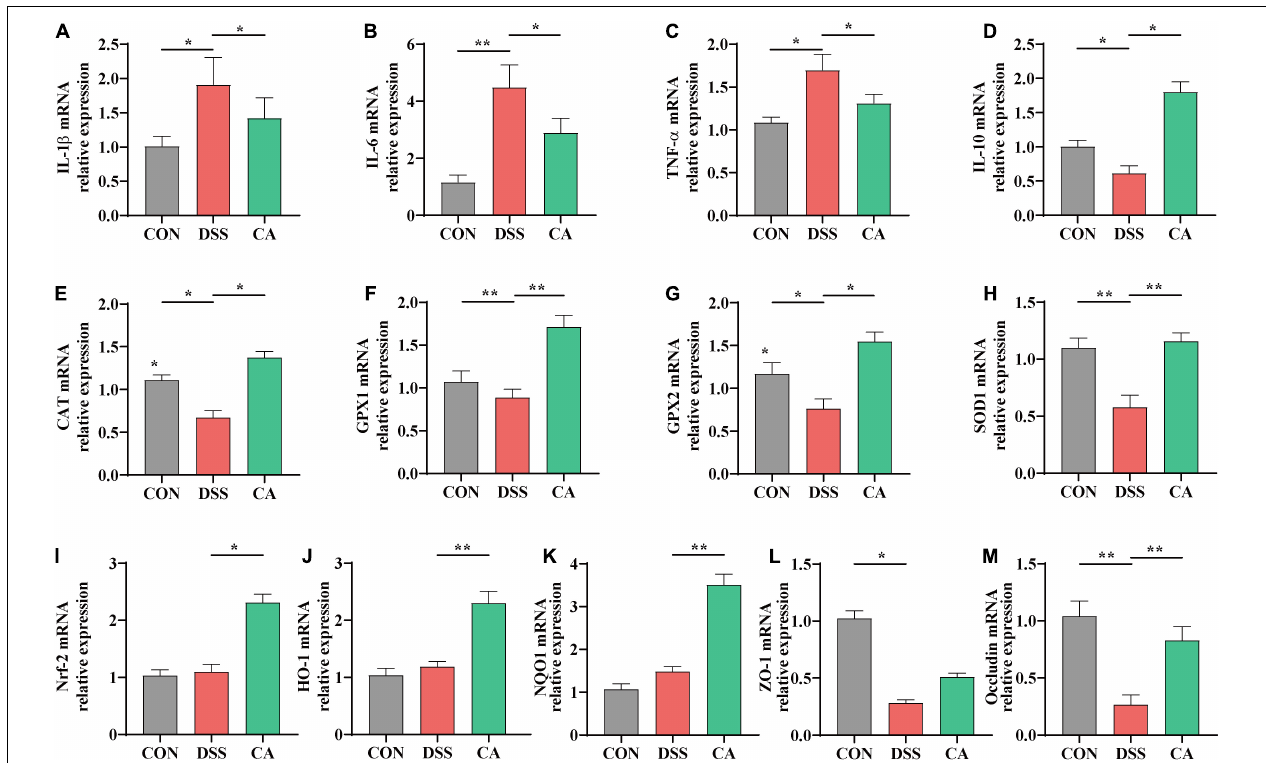
FIGURE 4 | Effects of CA supplementation on colon inflammation cytokine, antioxidant parameters, and expression of Nrf2 target gene mRNAs in the colon in DSS-induced colitis mice. (A) IL-1 β . (B) IL-6. (C) TNF- α . (D) IL-10. (E) CAT. (F) GPX1. (G) GPX2. (H) SOD1. (I) Nrf-2. (J) HO-1. (K) NQO1 (L) ZO-1. (M) Occludin. Data are presented as mean ± SEM; n = 10. * p < 0.05 and ** p < 0.01 vs. the DSS-treated